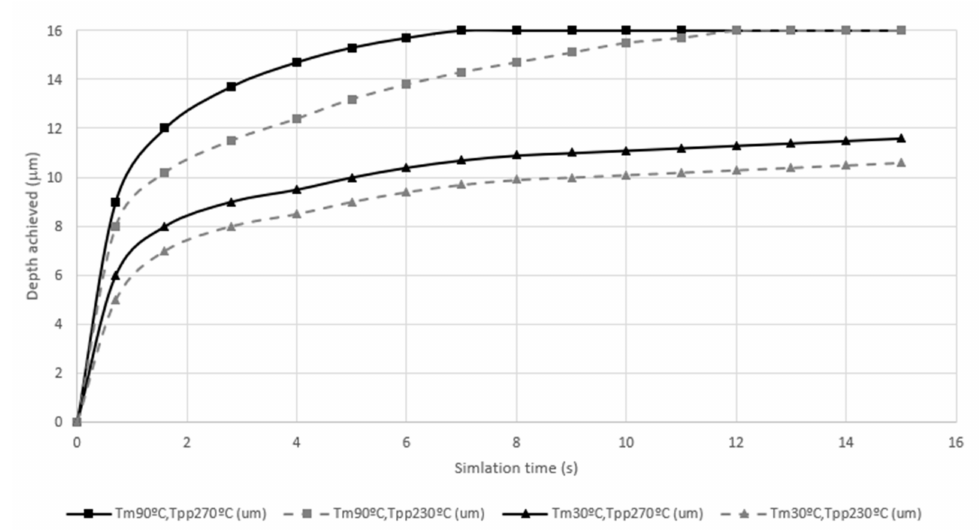
Figure 7. Y coordinate evolution of the bottom-middle corner point on different conditions vs. time (s).